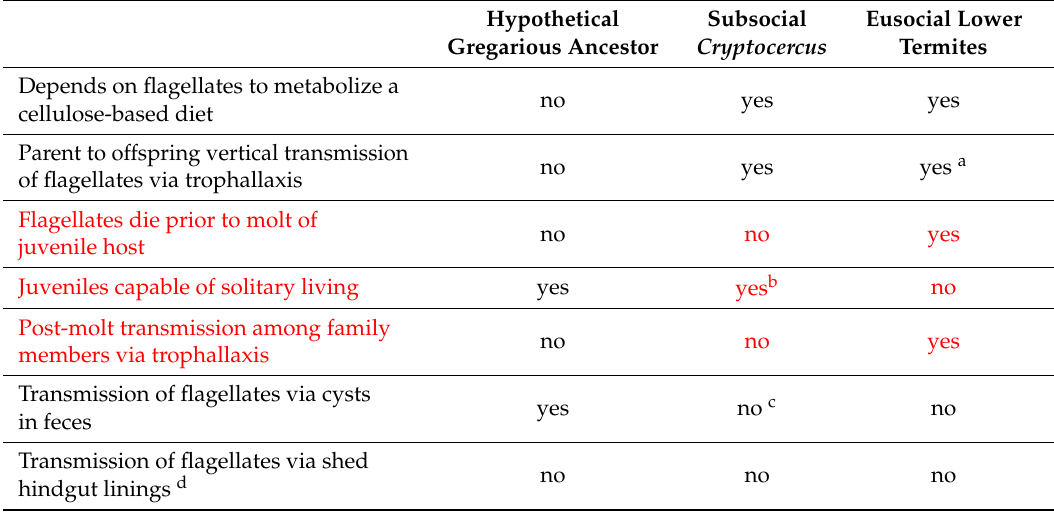
Table 1. Comparison of the host-flagellate relationship in a hypothetical cockroach ancestor, the wood-feeding cockroach Cryptocercus, and the lower termites. Characteristics of Cryptocercus are assumed to be the state immediately ancestral to lower termites. Key differences between Cryptocercus and lower termites are in